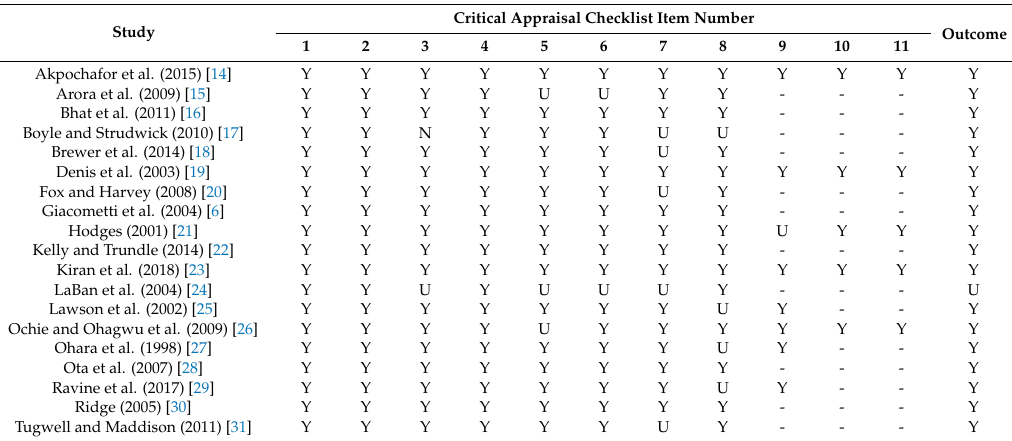
Table 5. Methodological quality of included